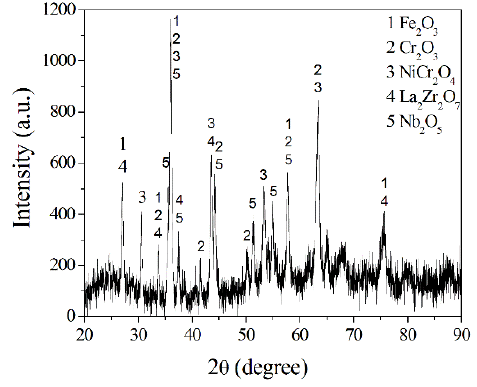
Figure 9. XRD patterns of the coating after high temperature oxidation at 1100 °C for 110 h.